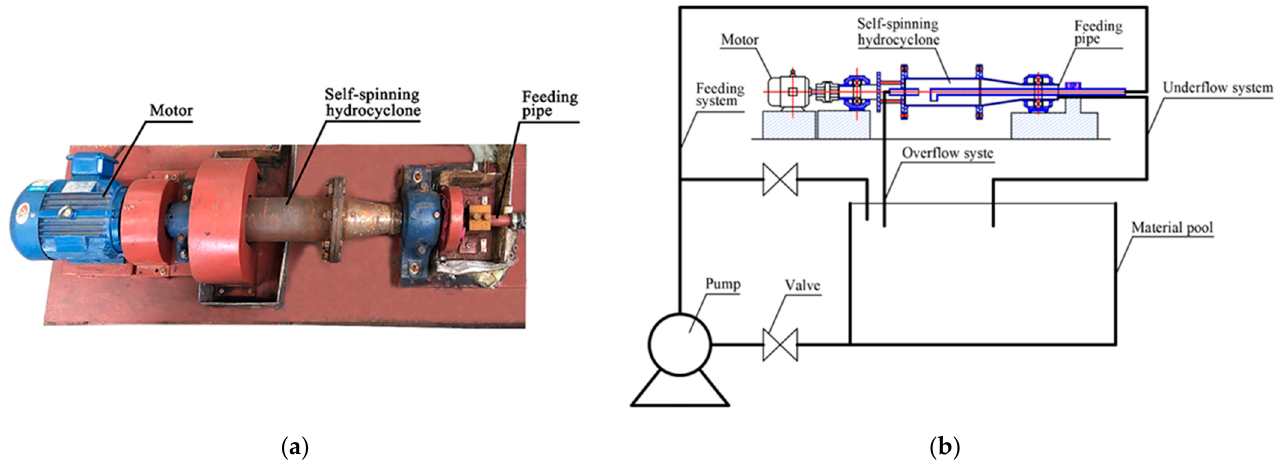
Figure 4. ( a ) Physical model of the self-spinning hydrocyclone; ( b ) the self-spinning hydrocyclone test system.